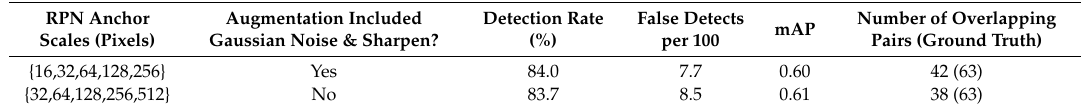
Table 1. Mask R-CNN results on single metal stain (test set